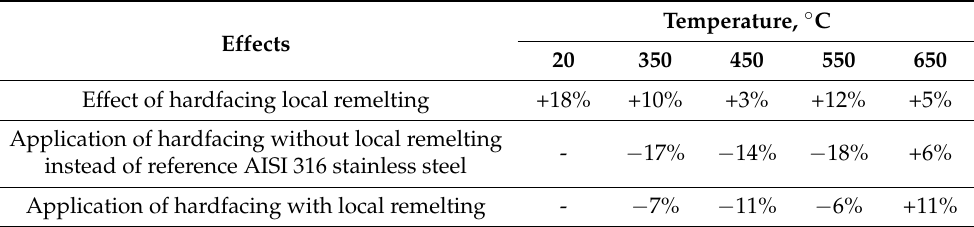
Table 6. Comparison of effects (application of remelting; reference vs. hardfacing with or without remelting) providing increase (+) or decrease ( − ) of wear rate of studied materials (average wear rates of the groups measured at 80 m · s − 1 with impact angle of 30 ◦ are compared).